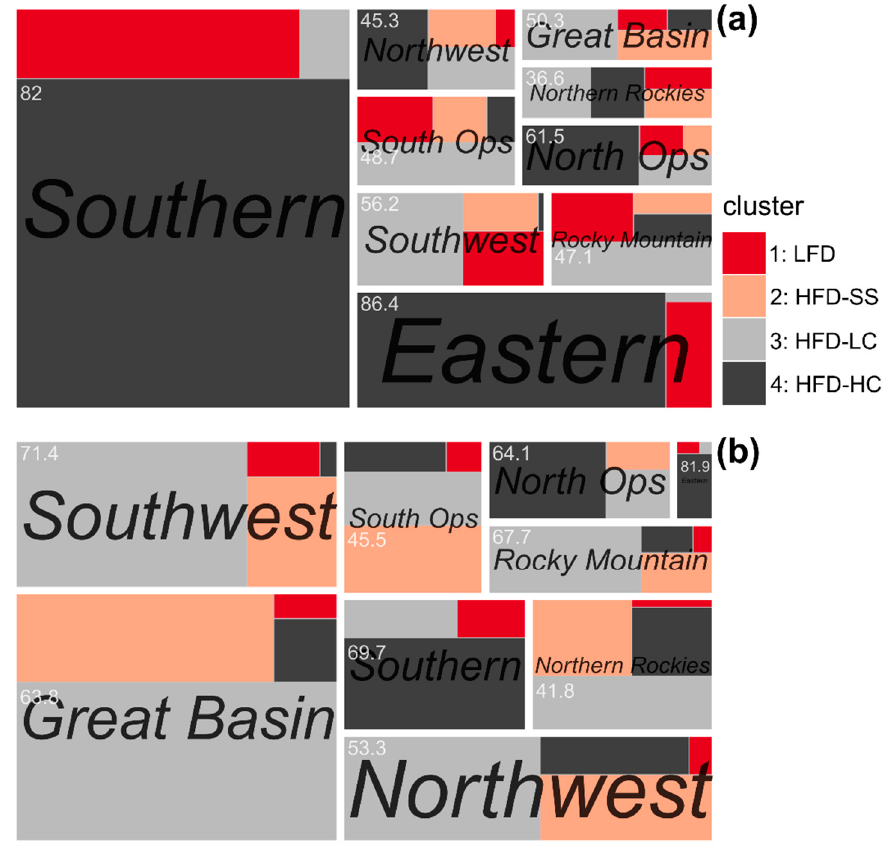
Figure 10. Treemap showing the proportional area of the number of fires ( a ) and area burned ( b ), relative to the total number of fires (1992–2017) and total area burned (1984–2017), respectively, by cluster type for each Geographic Area Coordination Center (GACC). The value of the cluster with the highest proportion (%), relative to each GACC, is shown in the upper left-hand corner.